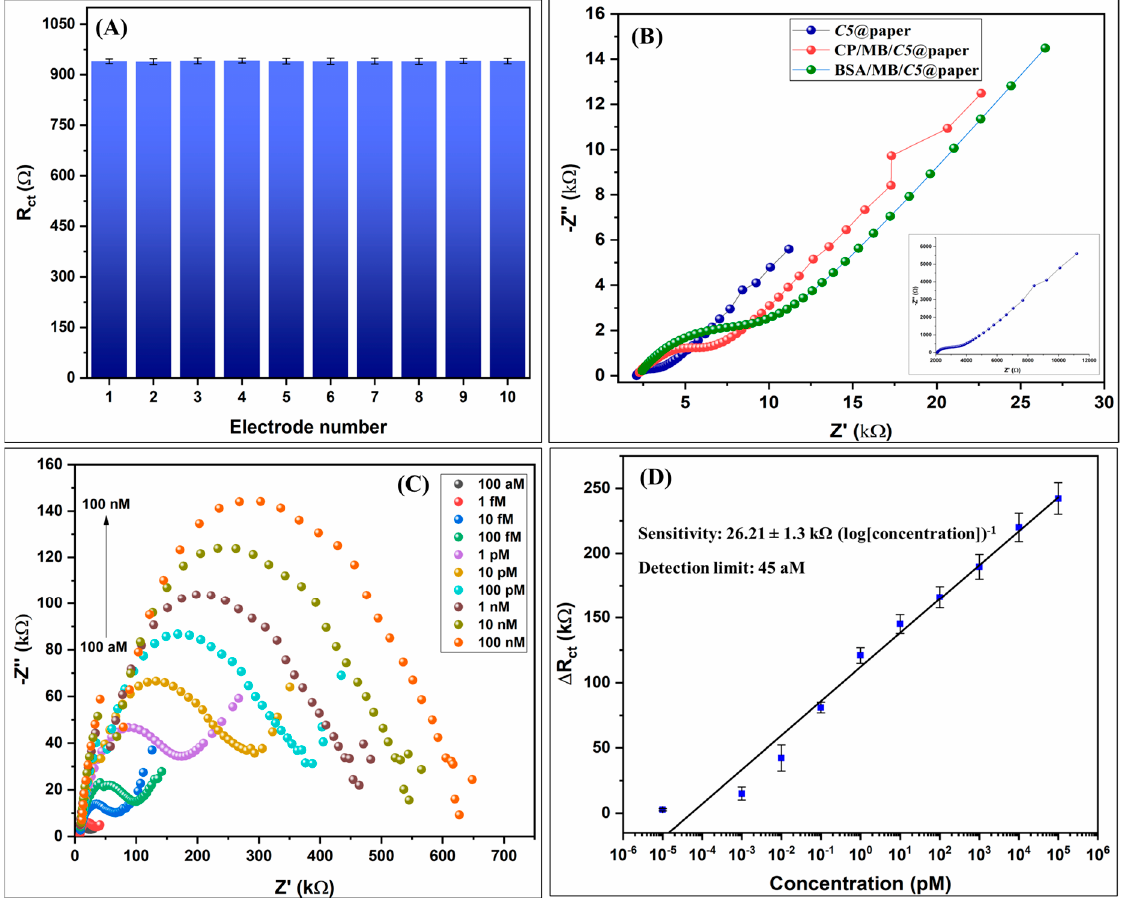
Figure 3. ( A ) Bar graph showing the R ct values of C5@paper electrodes selected randomly from different batches. ( B ) Nyquist plots of the C5 @paper, SCP/MB/ C5 @paper, and the BSA/SCP/MB/ C5 @paper electrodes. Inset shows the Nyquist plot of the C5 @paper electrode. ( C ) Nyquist plots of the C5 @paper after drop-casting of the SD-T-SC/MB for di ff erent concentrations of the TP. ( D ) Corresponding linear calibration curve showing Δ R ct vs. log of the concentration of the TP.